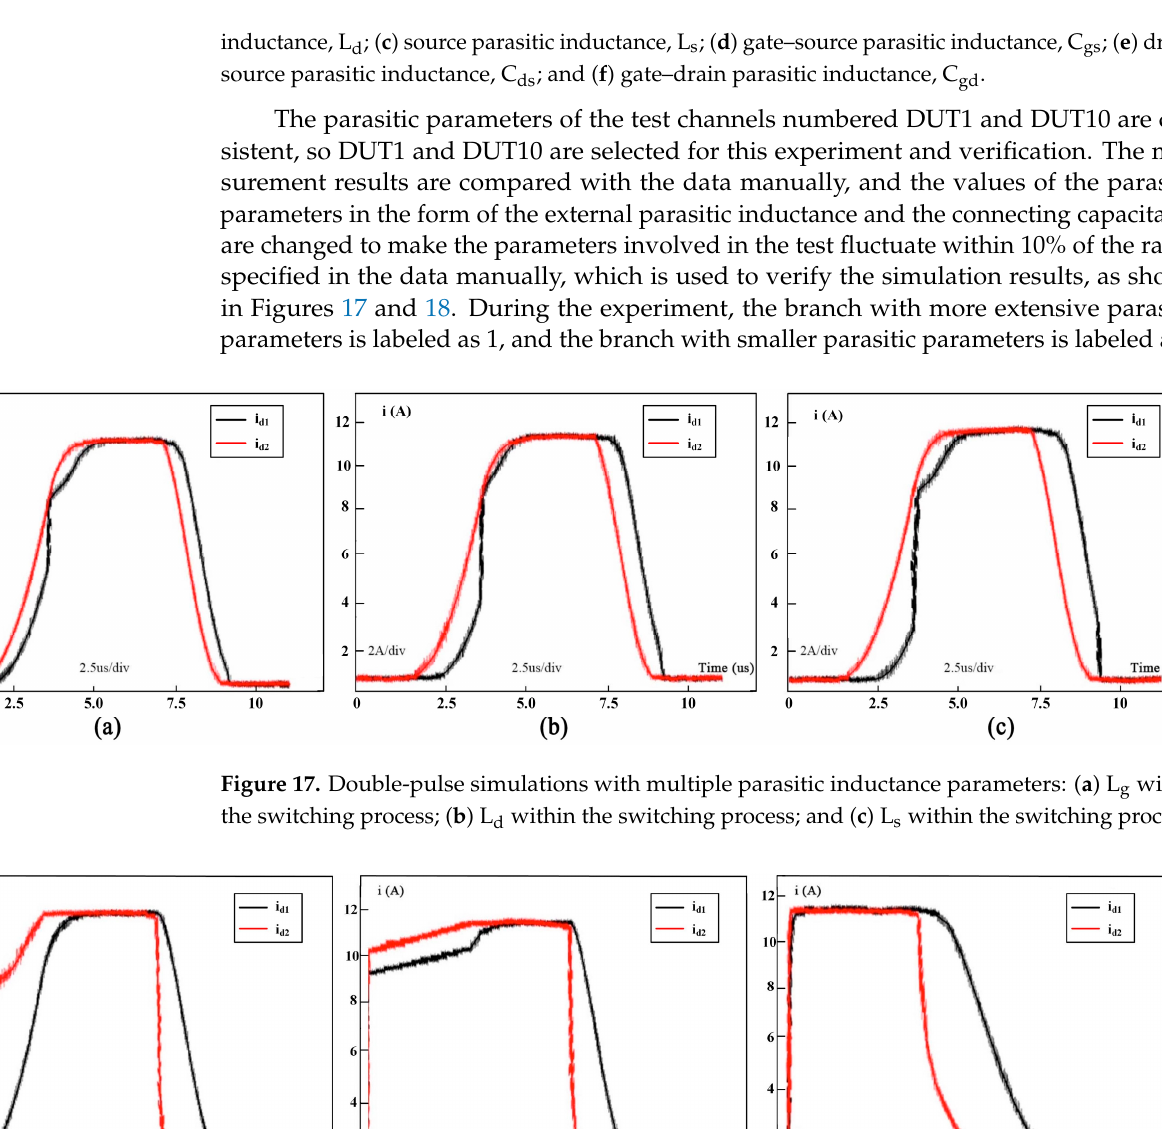
Machines 2023 , 11 , x FOR PEER REVIEW 14 of 19 drain parasitic inductance, L d ; ( c ) source parasitic inductance, L s ; ( d ) gate–source parasitic induct- ance, C gs ; ( e ) drain–source parasitic inductance, C ds ; and ( f ) gate–drain parasitic inductance, C gd .